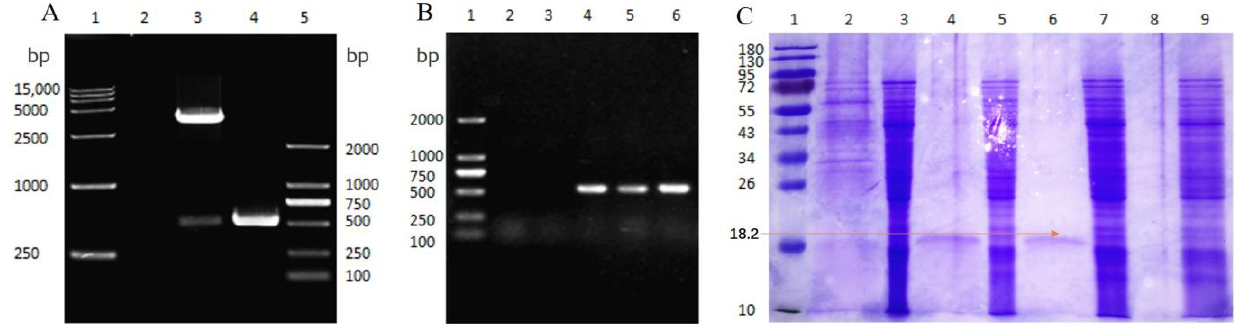
Figure 2. Construction and expression of LySP2. ( A ) Verification of pPICZ – LySP2 by enzyme